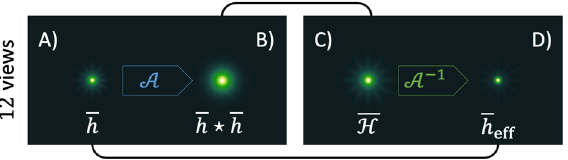
Figure 2. Point-spread-functions analysis. ( A ) PSF that blurs o µ . ( B ) Auto-correlation of h . ( C ) PSF H that blurs the average χ µ . ( D ) Corresponding PSF in the object domain, sharper than h